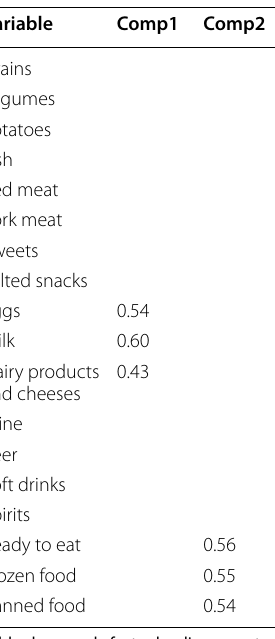
Table 4 Components identified by means of PCA